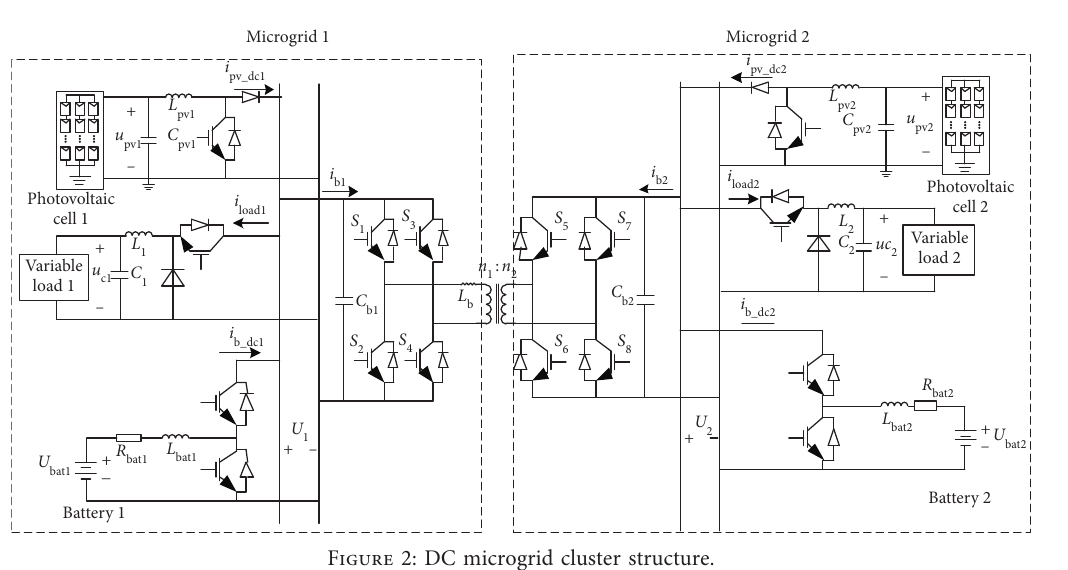
Figure 2: DC microgrid cluster